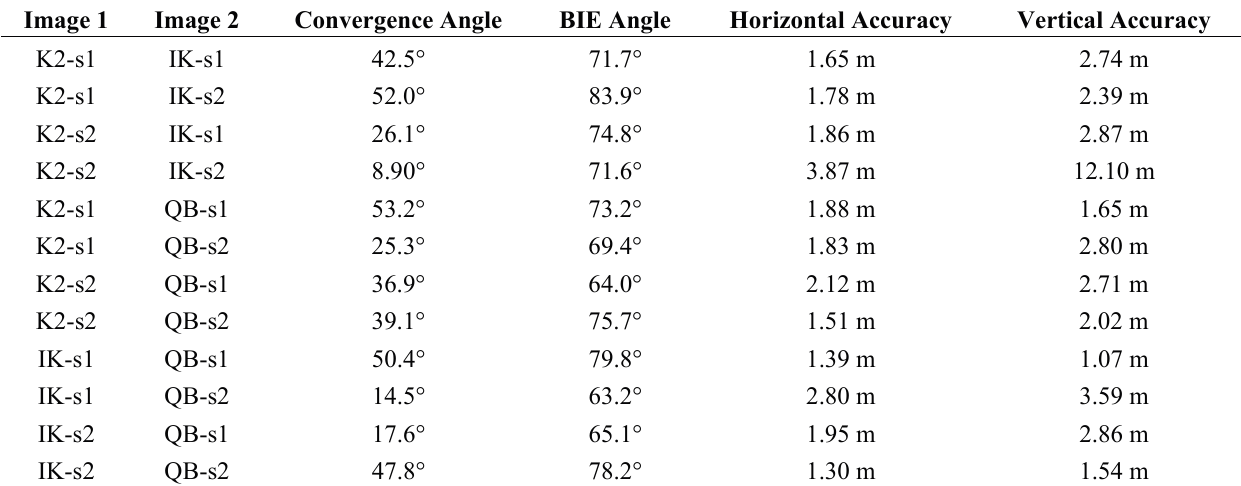
Table 3. Mapping accuracy of two different satellite